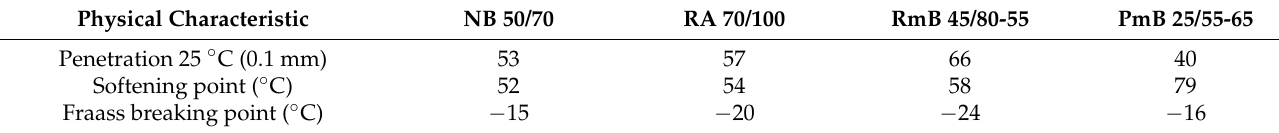
Table 1. Physical characteristics of the binders of asphalt mixtures.